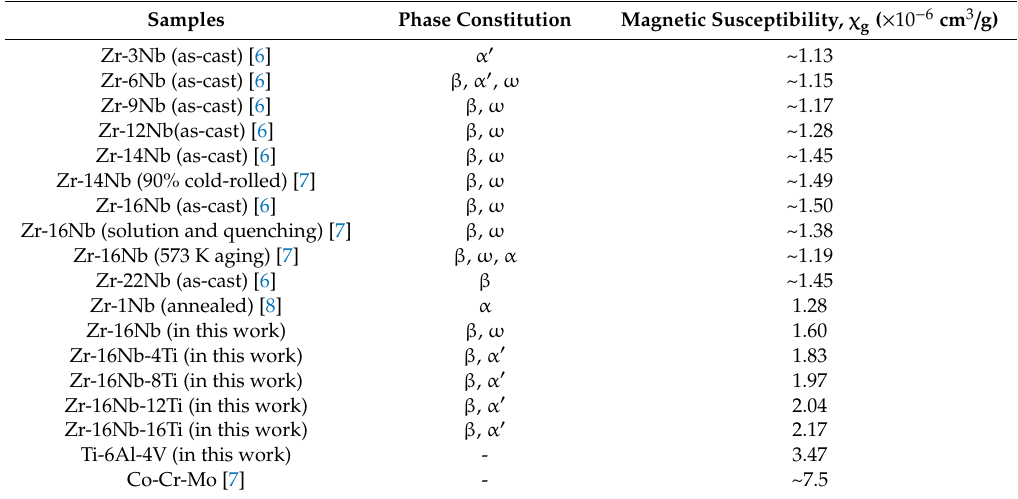
Table 5. Magnetic susceptibility of the Zr-Nb alloys and typical implant biomaterials.